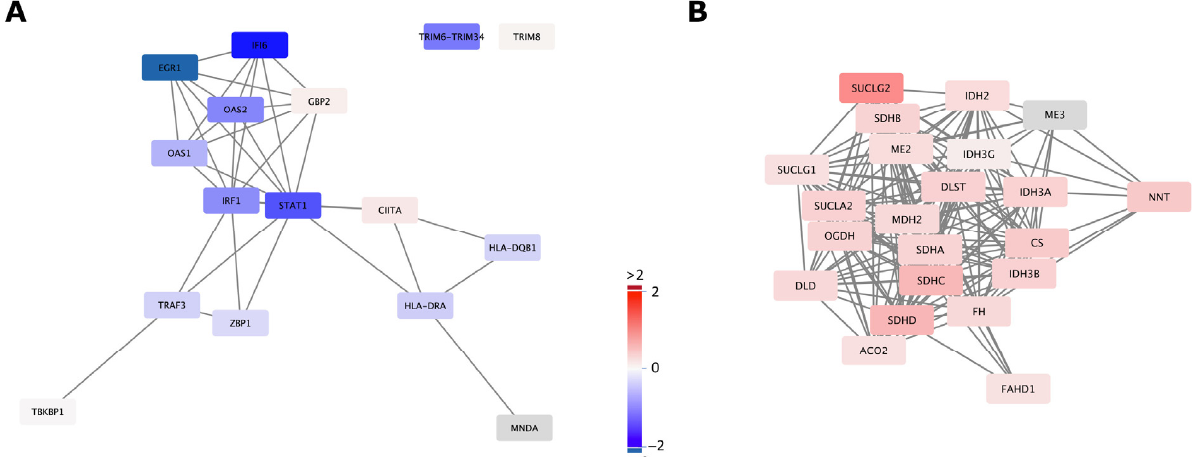
Figure 4. Gene network and differential gene expression of functional pathways identified by enrichment analysis. ( A ) Interferon signalling pathway (R-HSA-913531) genes expressed in tissues were used to construct a protein interaction network by STRING. Levels of differential gene expression between control and mtDNA-supplemented-derived liver are shown as fold change relative to control by colour scale (right). ( B ) The tricarboxylic acid (TCA) cycle pathway (R-HSA-71403) genes expressed in tissues were used to construct a protein interaction network. Levels of differential gene expression between heterologous and autologous mtDNA-supplemented-derived brain are shown as fold change relative to autologous mtDNA-supplemented-derived brain by colour scale. The same colour scale was used as shown in ( A ). Genes displayed in grey boxes have no DEG data due to low or no expression in the corresponding tissues.